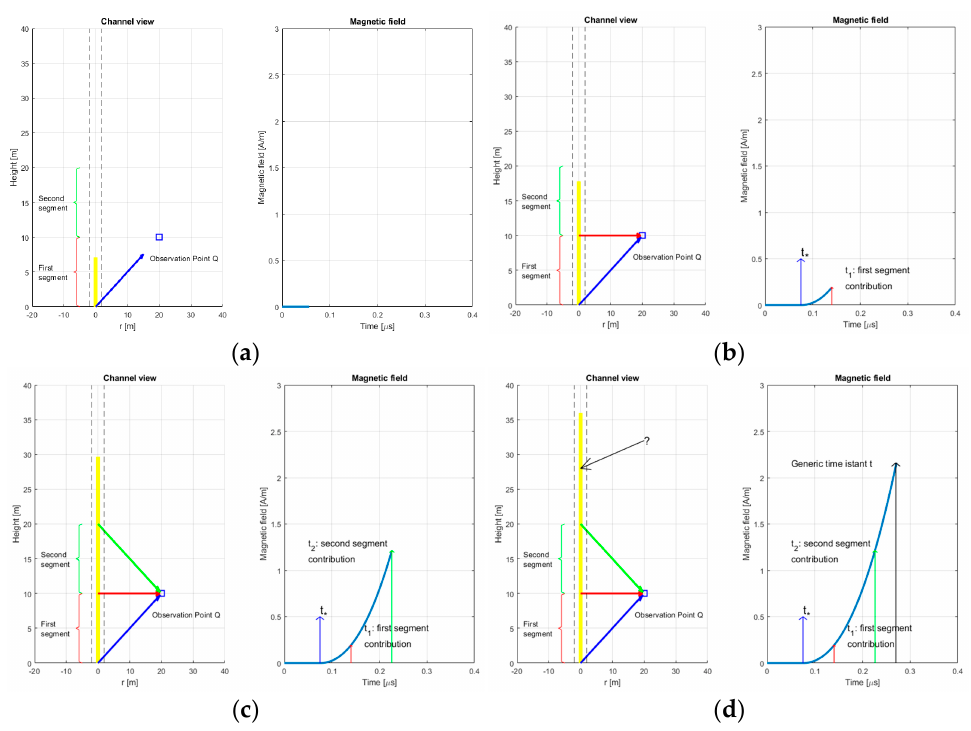
Figure 2. Graphical sketches showing the time intervals at which the different channel segments contribute to the field at the observation point Q: t ≤ t ∗ in panel ( a ); t ∗ ≤ t ≤ t 1 in panel ( b ); t 1 ≤ t ≤ t 2 in panel ( c ); generic t ≥ t 2 in panel ( d